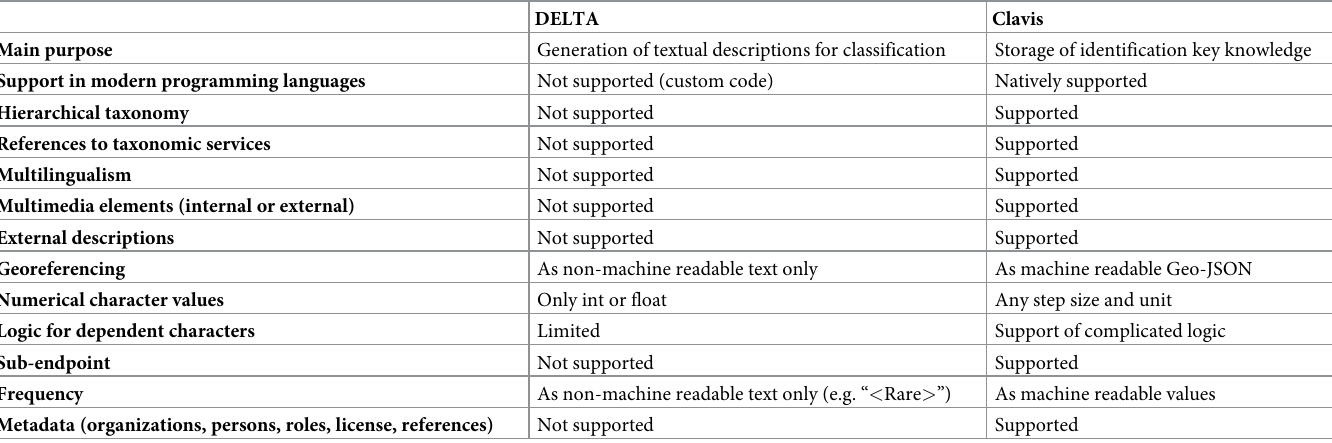
Table 1. Comparison of the DELTA and Clavis